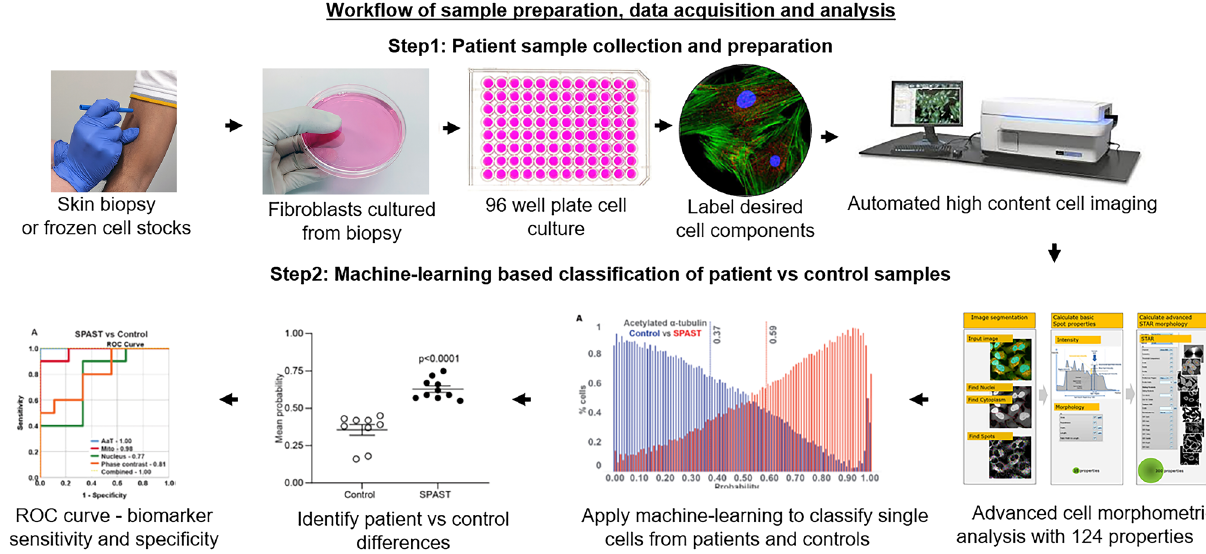
Figure 1. Overview of the workflow of the cellular morphology phenotypic biomarker development